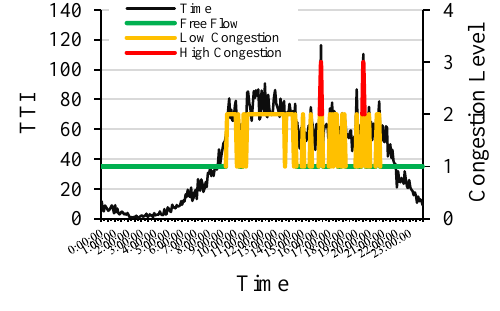
Figure 18. Congestion Levels estimated at Astley Hall for full